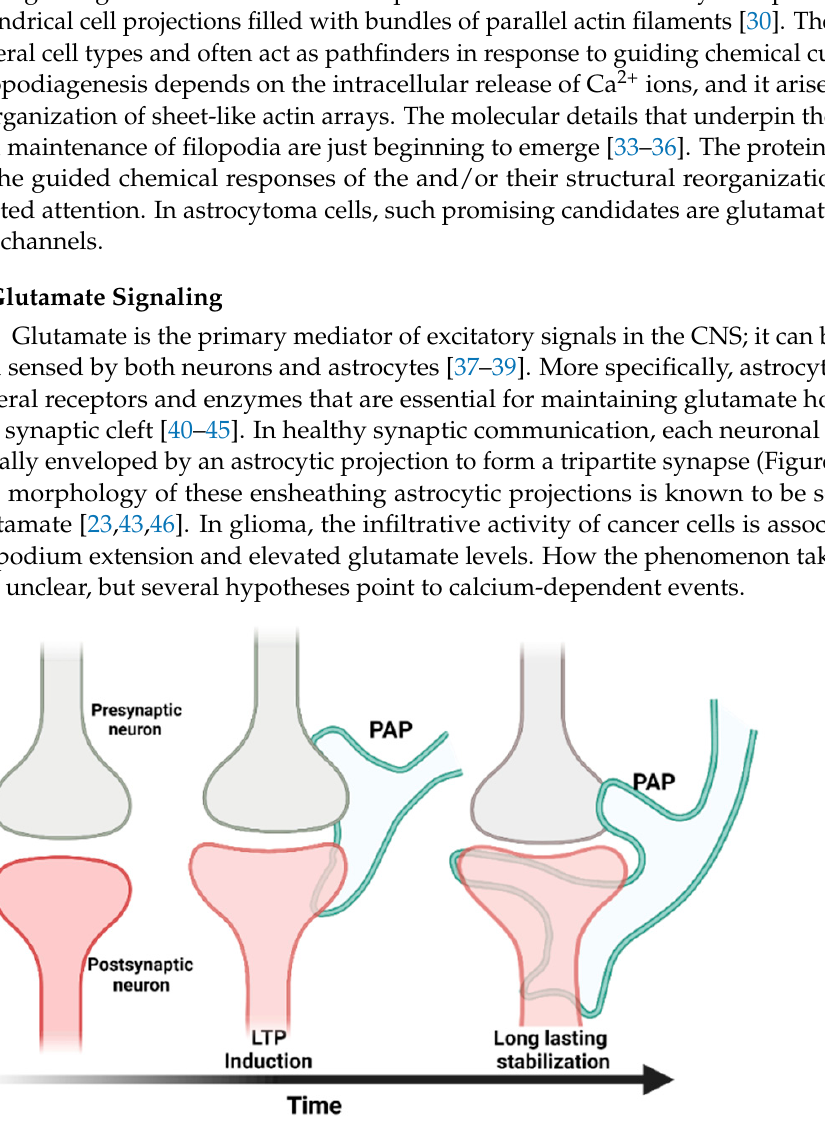
Figure 2. The tripartite synapse model. A tripartite synapse consists of a pre-synapse (gray), a post- synapse (red), and a perisynaptic astrocyte process (PAP, green). PAPs undergo structural changes in response to long-term potentiation. The growth of post-synaptic dendritic spines is associated with enhanced motility of PAPs, which increases their coverage of synapses and strengthens the synaptic connection